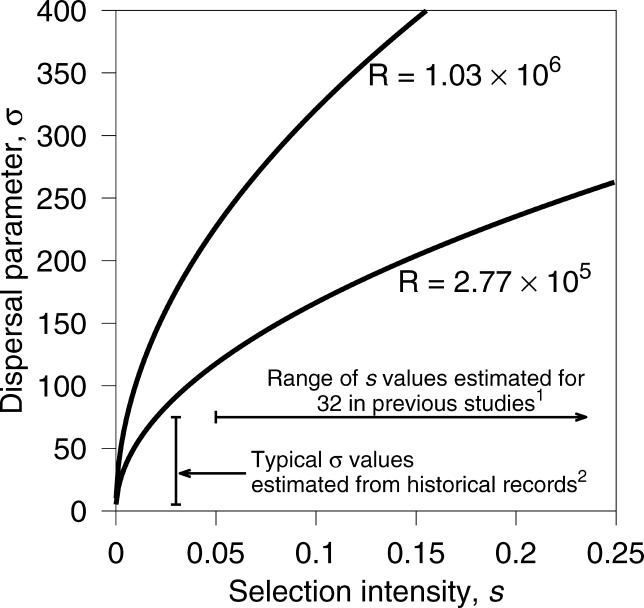
The Dispersal Parameter σ as a Function of the Selection Intensity s
The curves are drawn for the two MLEs of R and labeled accordingly. 1Based on estimates in [2] and [3]. 2From Table 1 of [27].